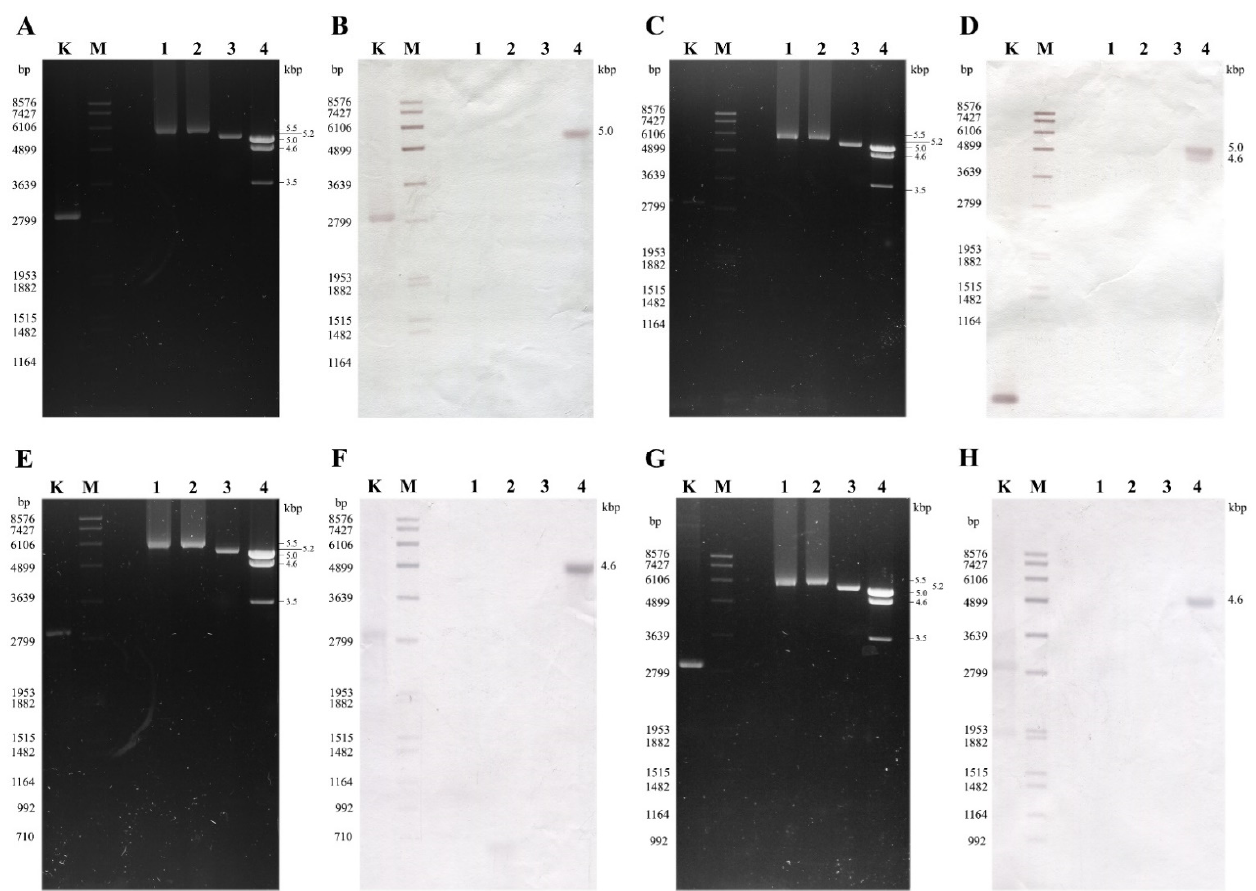
Figure 4. Northern blot analysis of dsRNA molecules purified from the mycovirus-harboring Mucor strains with probes designed using the MhV3 and MhV4 sequences. Panels ( A , C , E , G ): agarose gel electrophoresis of the dsRNA molecules purified from M. hiemalis f. hiemalis WRL CN(M) 122, M. hiemalis f. hiemalis NRRL 3624, M. hiemalis f. corticola NRRL 3617, and M. hiemalis f. corticola NRRL 3616. Lane K, control plasmid containing the corresponding PCR amplicon of virus genomes; Lane M, DIG-labeled DNA Molecular Weight Marker VII (Roche); Lane 1, M. hiemalis f. hiemalis WRL CN(M) 122; Lane 2, M. hiemalis f. hiemalis NRRL 3624; Lane 3, M. hiemalis f. corticola NRRL 3617; Lane 4, M. hiemalis f. corticola NRRL 3616. Right numbers indicate the sizes (kbp) of the detected dsRNA molecules. Panels ( B , D ): Northern blot analysis of the dsRNA molecules extracted from M. hiemalis f. corticola NRRL 3616 using the MhV3 CP and MhV3 RdRp probes, respectively. In panel ( B ), MhV3 CP probe gave strong hybridization signal to the largest, 5.0-kbp band and the Bgl II digested control plasmid, which contains the PCR amplicon of the MhV3 CP probe sequence. In panel ( D ), MhV3 RdRp probe gave strong hybridization signal to the largest, 5.0-kbp band but also hybridized to the 4.6-kbp band. The Bgl II digested control plasmid containing the PCR amplicon of the MhV3 RdRp probe sequence gave a strong hybridization signal with the MhV3 RdRp probe. Panels ( F , H ), Northern blot analysis of the dsRNA molecules purified from M. hiemalis f. corticola NRRL 3616 using the MhV4 CP and MhV4 RdRp probes, respectively. In both ( F , H ) panels, the probes designed for MhV4 CP and MhV4 RdRp sequences hybridized to the second largest, 4.6-kbp band and the Bgl II digested control plasmid, which contains the PCR amplicon of the MhV4 CP and MhV4 RdRp probe